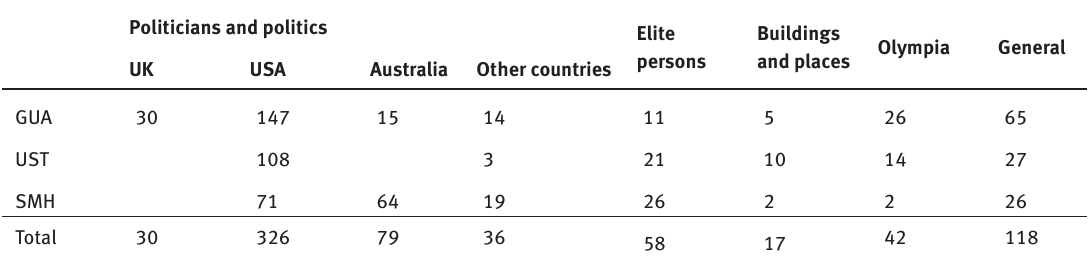
Table 4: Number of images not depicting migration